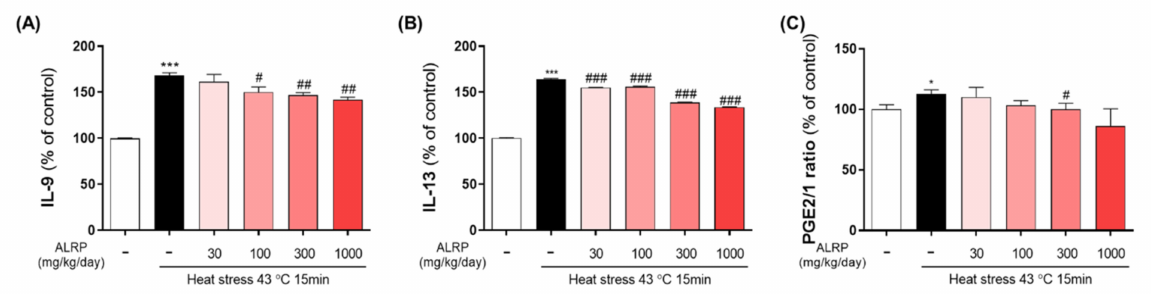
Figure 4. Inhibitory effect of ALRP on increases of IL-9, IL-13 and ratio of PGE2/PGE1. In hypothalamus of mice after heat exposure, the presences of IL-9 ( A ), IL-13 ( B ) and ratio of PGE2/PGE1 ( C ) were determined using sandwich ELISA kit (n = 6 per group). Values are expressed as means ± SEM. * p < 0.05 and *** p < 0.001 as compared with the control group. # p < 0.05, ## p < 0.01 and ### p < 0.001 as compared with the heat-stressed vehicle-treated group. ALRP; Aconiti Lateralis Radix Preparata. IL-9; interleukin-9. IL-13; interleukin-13. PGE1; prostaglandin 1. PGE2; prostaglandin 2.